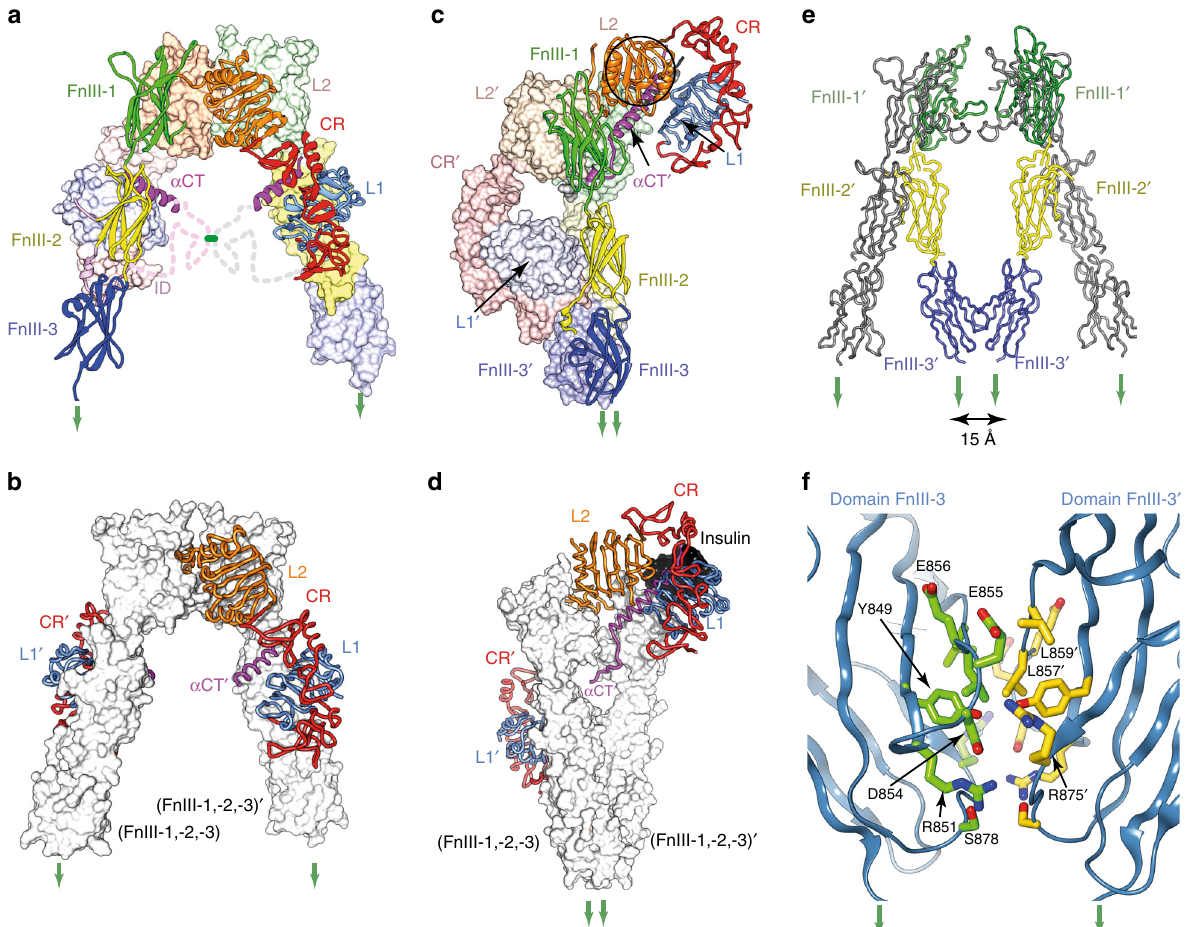
Fig. 2 Comparison of the cryo-EM structure of IR Δβ -zipInsFv with the crystal structure of apo IR Δβ . a Domain arrangement in apo IR Δβ (left) with domains colored as in Fig. 1a. b Apo IR Δβ but with only domains L1, CR, L2, L1 ′ , CR ′ , and α CT ′ shown in color (for comparison with panel ( d )). c Domain arrangement in IR Δβ -zipInsFv with domains colored as in Fig. 1a. d IR Δβ -zipInsFv but with only domains L1, CR, L2, L1 ′ , CR ′ , and α CT ′ shown in color in order to highlight the rearrangement of the insulin-bound (L1-CR-L2) + α CT ′ module with respect to apo IR Δβ (panel ( b )). e Comparison of the relative disposition of domains FnIII and FnIII ′ in apo IR Δβ (grey) and in IR Δβ -zipInsFv (colored). f Pseudo-two-fold-symmetric interaction of domains FnIII-3 and FnIII-3 ′ within IR Δβ -zipInsFv. For clarity, only one member of each pseudo-symmetry-related residue pair is labeled. Green arrows in all panels indicate the direction of membrane entry. Panel ( a ) is adapted from Fig. 1a of Xu et al.